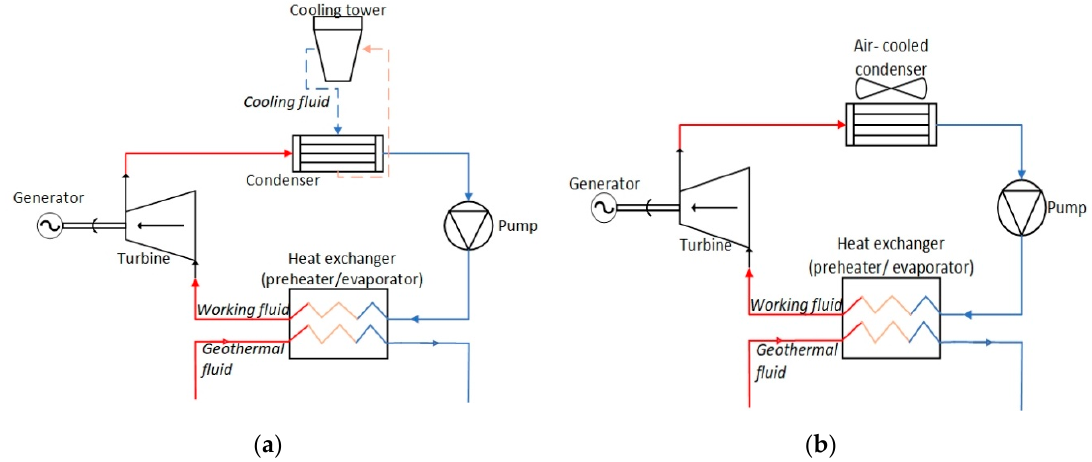
Figure 5. Schematic diagram of a basic binary cycle geothermal power plant: ( a ) water-cooled condenser and ( b ) air-cooled condenser.